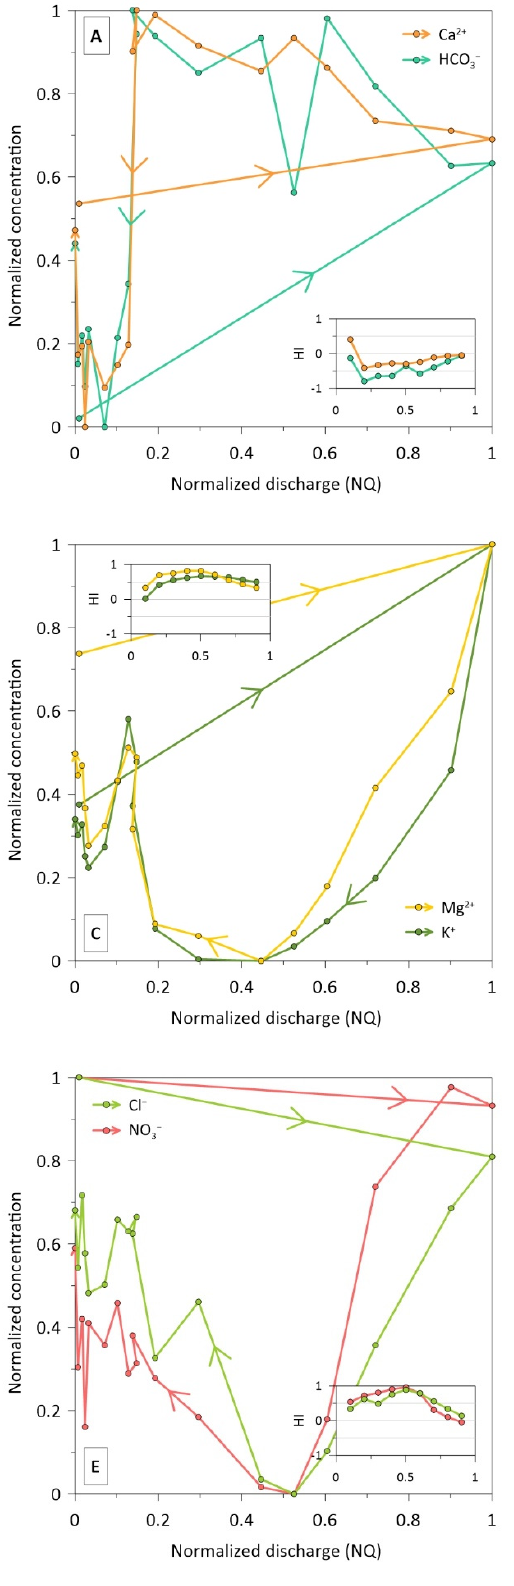
Figure 5. Normalized hysteresis loops for major elements: ( A ) for Ca 2+ and HCO 3 − , ( B ) SO 42 − , ( C ) Mg 2+ and K + , ( D ) Si and Na + , ( E ) Cl − and NO 3 − and, ( F ) DOC, during the flood event No. 3. Small plots show the hysteresis index (HI) vs. the normalized discharge for each element during the flood episode.